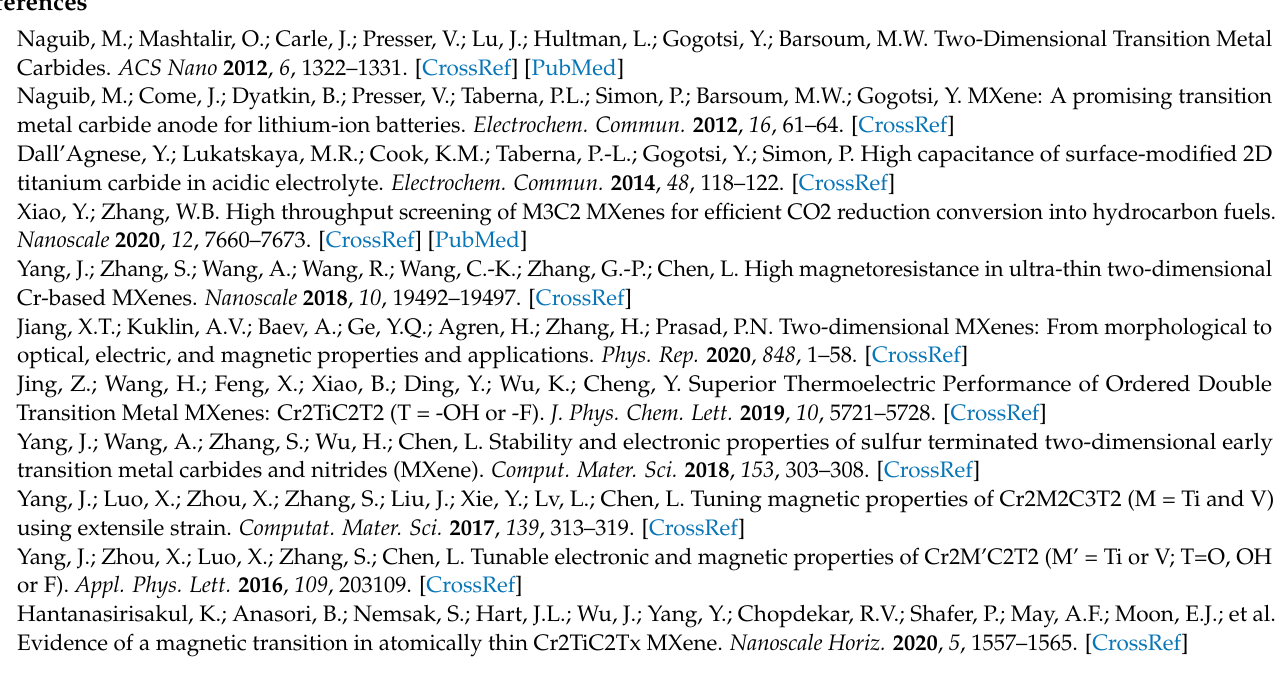
Figure S3: The energy differences between AFM1 and FM states ( ∆ E AFM1 ) of Cr 2 TiC 2 F 2 and the total magnetic moments of Cr 2 TiC 2 F 2 FM under different Hubbard U of Cr atoms (UCr); Figure S4: The number of electrons of Cr atoms (e Cr ), the magnetic moment of Cr atoms (M Cr ), and energy difference of AFM1, AFM2, AFM3 with FM state of Cr 2 TiC 2 O n/4 ; Figure S5: Variations of T N or T C with n for Cr 2 TiC 2 O n/4 F 2-n/4 and Cr 2 TiC 2 O n/4 ; Figure S6: Total density of states for FM and AFM1 Cr 2 TiC 2 , Cr 2 TiC 2 O 1/2 (C1), Cr 2 TiC 2 O (C5), Cr 2 TiC 2 O 3/2 (C1); Table S1: J1, J2, J3, MAE, T N , and T C of Cr 2 TiC 2 O n/4